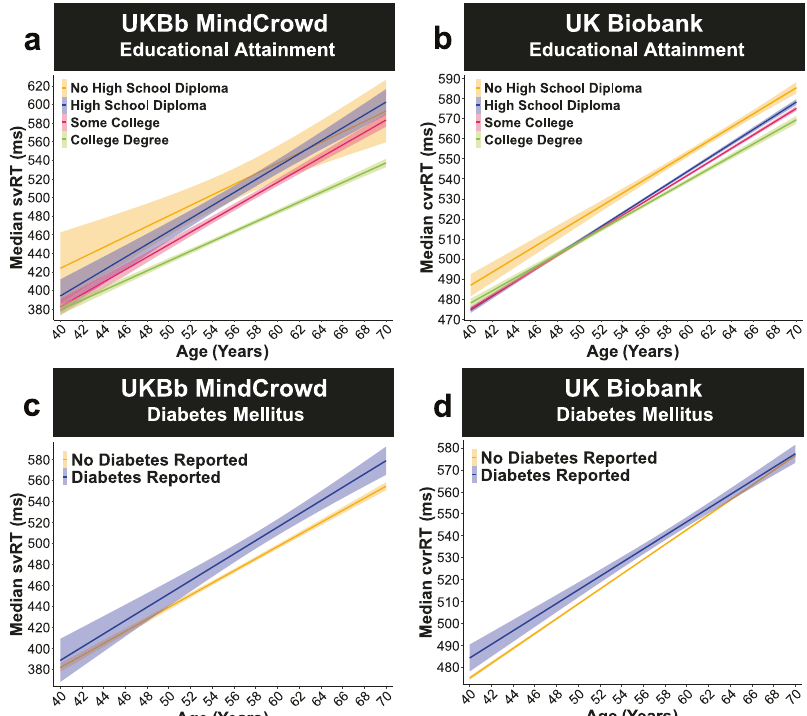
Fig. 5 UK Biobank: educational attainment and diabetes mellitus. UKBb MindCrowd and UK Biobank analysis (ages 40 – 70) of visual reaction time (RT). a – b More education was related to shorter visual RT. a UKBb MindCrowd linear model fi ts (line fi ll ±95% CI) of median simple visual RT (svRT) from young to old Age with lines split by Educational Attainment. Participants who had a “ High School Diploma ” ( β HSDiploma = − 9.68, p HSDiploma = 2.70E − 01, 1.87% , n = 3176), “ Some College ” ( β College = − 26.08, p College = 1.61E − 03, 5.06%, n = 11,139), or a “ College Degree ” ( β CDegree = − 49.07, p CDegree = 1.91E − 09, 9.51%, n = 24,875) were shortened than those with “ No High School Diploma ” ( n = 605). b UK Biobank linear model fi ts (line fi ll ±95% CI) of median complex visual recognition RT (cvrRT) from young to old Age with lines split by Educational Attainment. Like the UKBb MindCrowd cohort, participants who had a “ High School Diploma ” ( β HSDiploma = − 9.68, p HSDiploma = 1.23E − 33, 1.74% , n = 46,247), “ Some College ” ( β College = − 10.26, p College = 1.30E − 40, 1.85%, n = 77,270), or a “ College Degree ” ( β CDegree = = 1.46E − 41, 2.11%, n = 23,750) were all associated with shorter cvrRTs when compared to “ No High School Diploma ” ( n = − 11.71, p CDegree 10,978). c – d Diabetes Mellitus was associated with lengthened visual RT. c UKBb MindCrowd linear model fi ts (line fi ll ±95% CI) of median svRT from young to old Age with lines split by diabetes mellitus. d UK Biobank linear model fi ts (line fi ll ±95% CI) of median cvrRT from young to old Age with lines split by diabetes mellitus. For the UKBb MindCrowd, individuals who reported ( β Diabetes = 11.48, p Diabetes = 3.31E − 03, Diabetes Reported n = 2807, No Diabetes Reported n = 36,988) and UK Biobank cvrRT ( β Diabetes = 5.48, p Diabetes = 4.80E − 07, Diabetes Reported n = 4969, No Diabetes Reported n = 153,276), were associated with lengthened